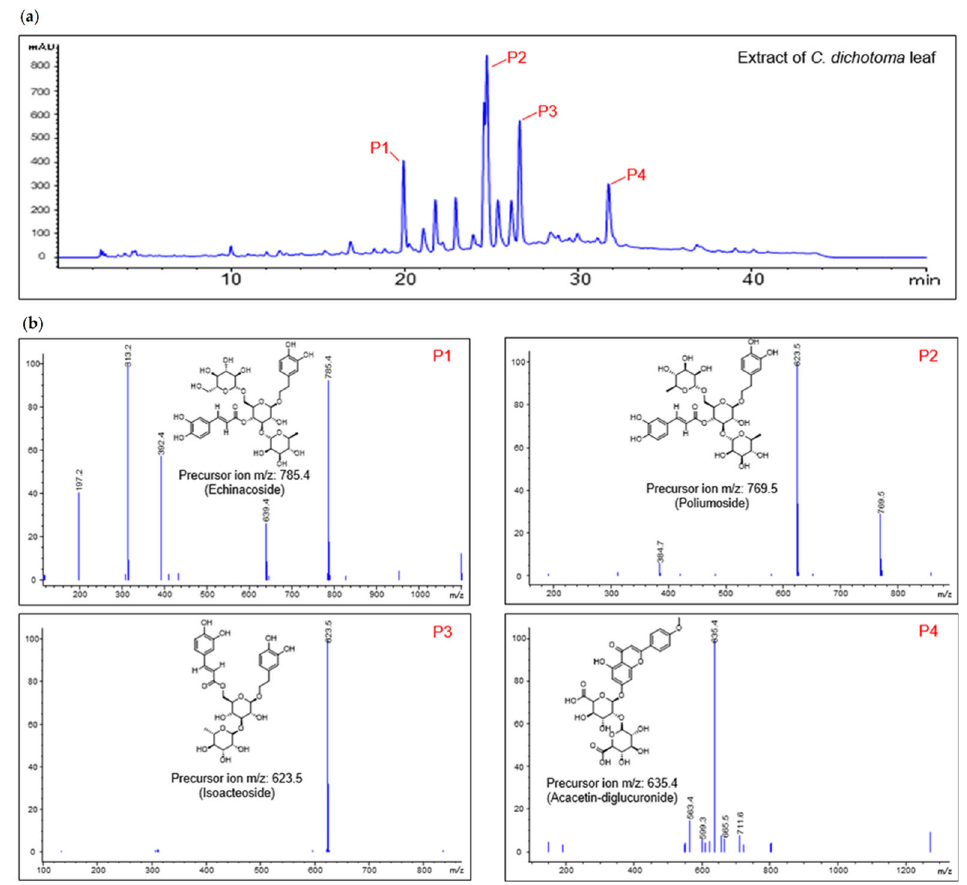
Figure 1. Major ingredient chemoprofile of CDE. ( a ) HPLC-MS chromatograms of CDE peaks. ESI-MS spectra of each compound precursor ion ([M-H] − ion) ( b ).